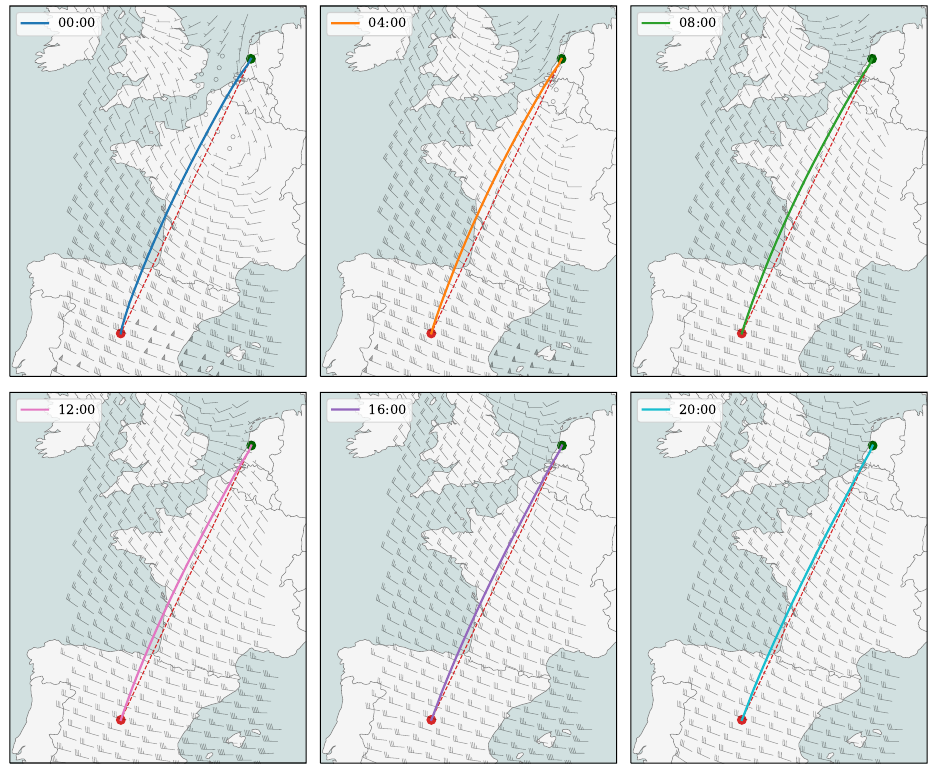
Figure 13. Optimal ground track of the same origin and destination under different wind conditions over the course of a day. The wind fields at cruise altitudes are shown for illustration purposes. It is possible to see that during the early hours, the optimizer can take advantage of the tailwind component during the second half of the flight, where it deviates from the shortest distance by achieving greater fuel optimality. In addition, due to the advantage of the tailwind, the flight time is also the shortest for the first wind